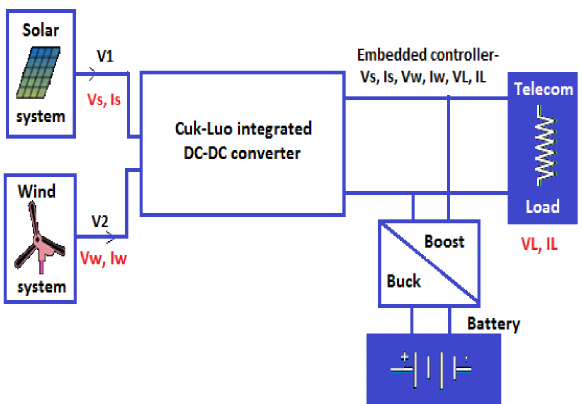
Figure 1. Overview and Block diagram of the proposed